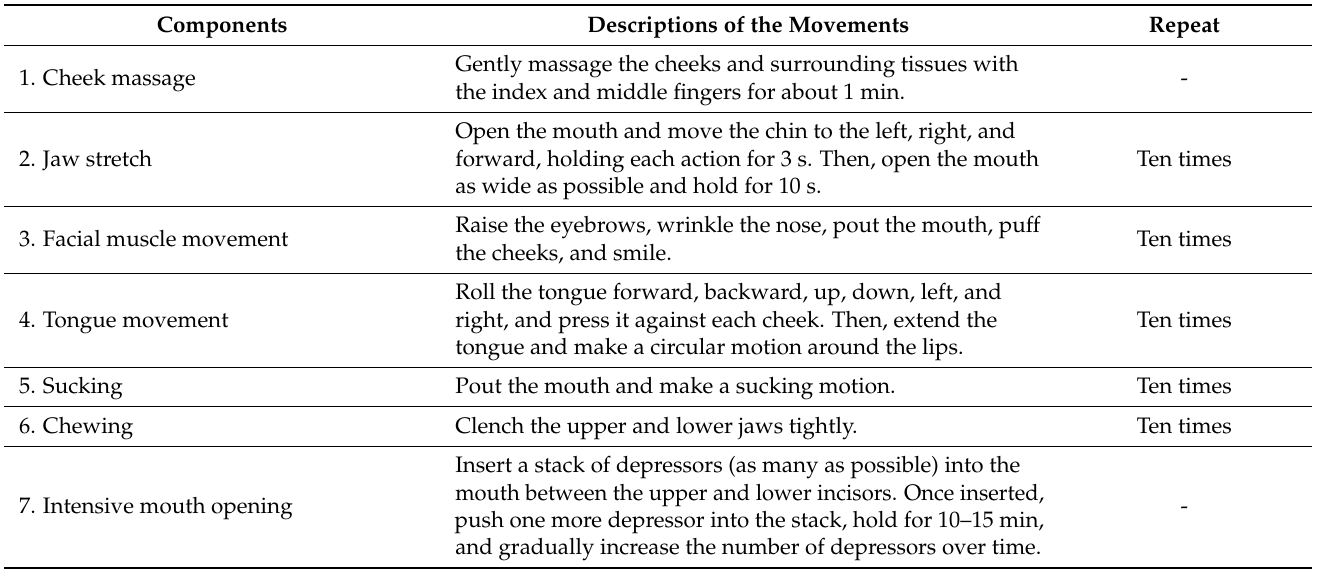
Table A1. Details of the oral exercise